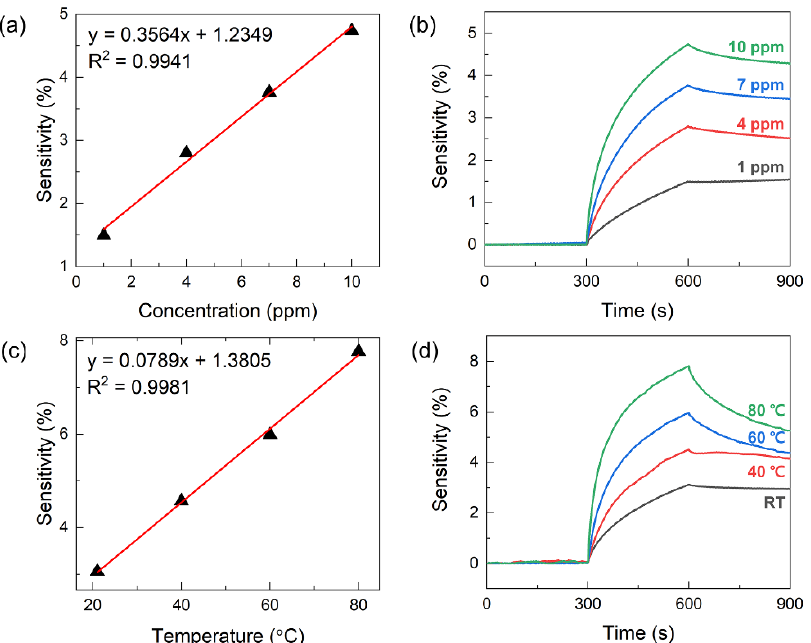
Figure 4. ( a , b ) The sensing responses of the MoS 2 gas sensor to different analyte NO 2 concentrations ranging from 1 to 10 ppm obtained from the two-gas inlet system with optimal configuration (the angle of 90° and the distance of 2 mm) under room temperature. ( c , d ) The sensing responses of the MoS 2 gas sensor to 5 ppm of the analyte NO 2 at different operating temperatures obtained from the two-gas inlet system with optimal configuration (the angle of 90° and the distance of 2 mm) under room temperature.